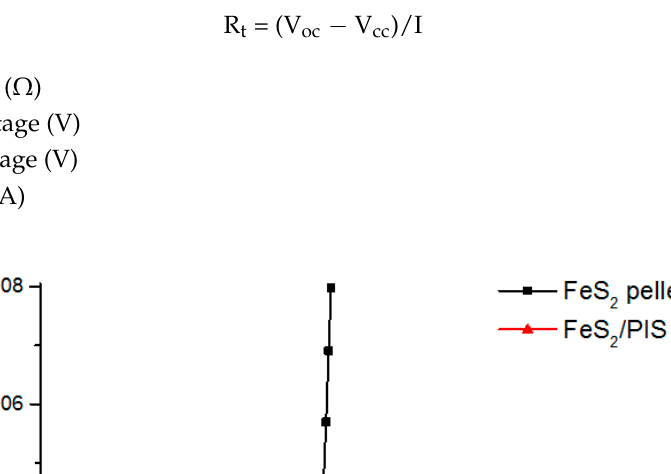
Figure 7. Total polarization for the FeS 2 /PIS thin layer cathode and the pellet-type FeS 2 .